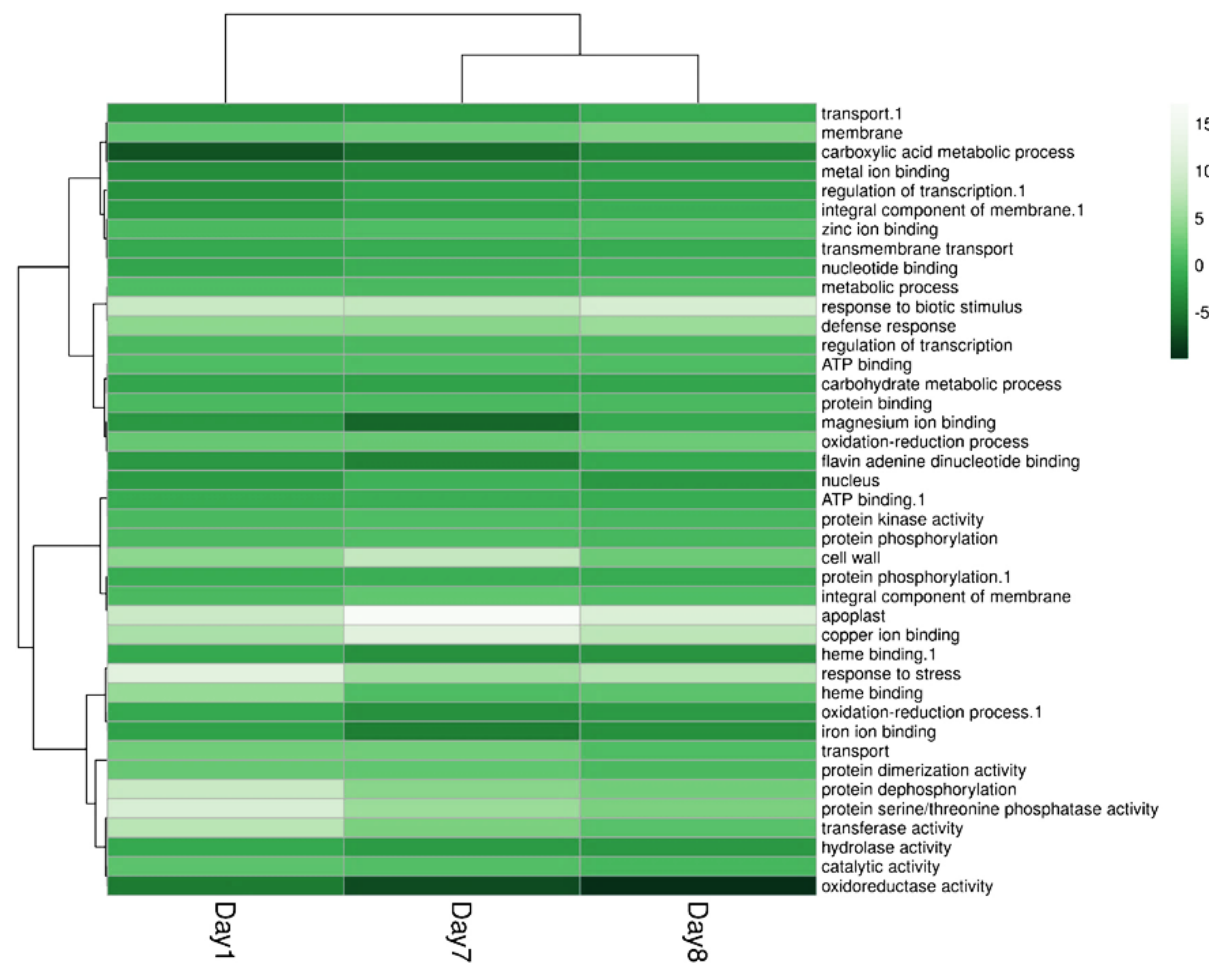
Figure 5. Hierarchical clustering of the main biological and molecular processes affected by ALPAN ® treatment under water deficit conditions (ALPAN + WD) in comparison to Mock + WD at day 1, 7, and 8. Heatmap was generated using Clustvis online tool.